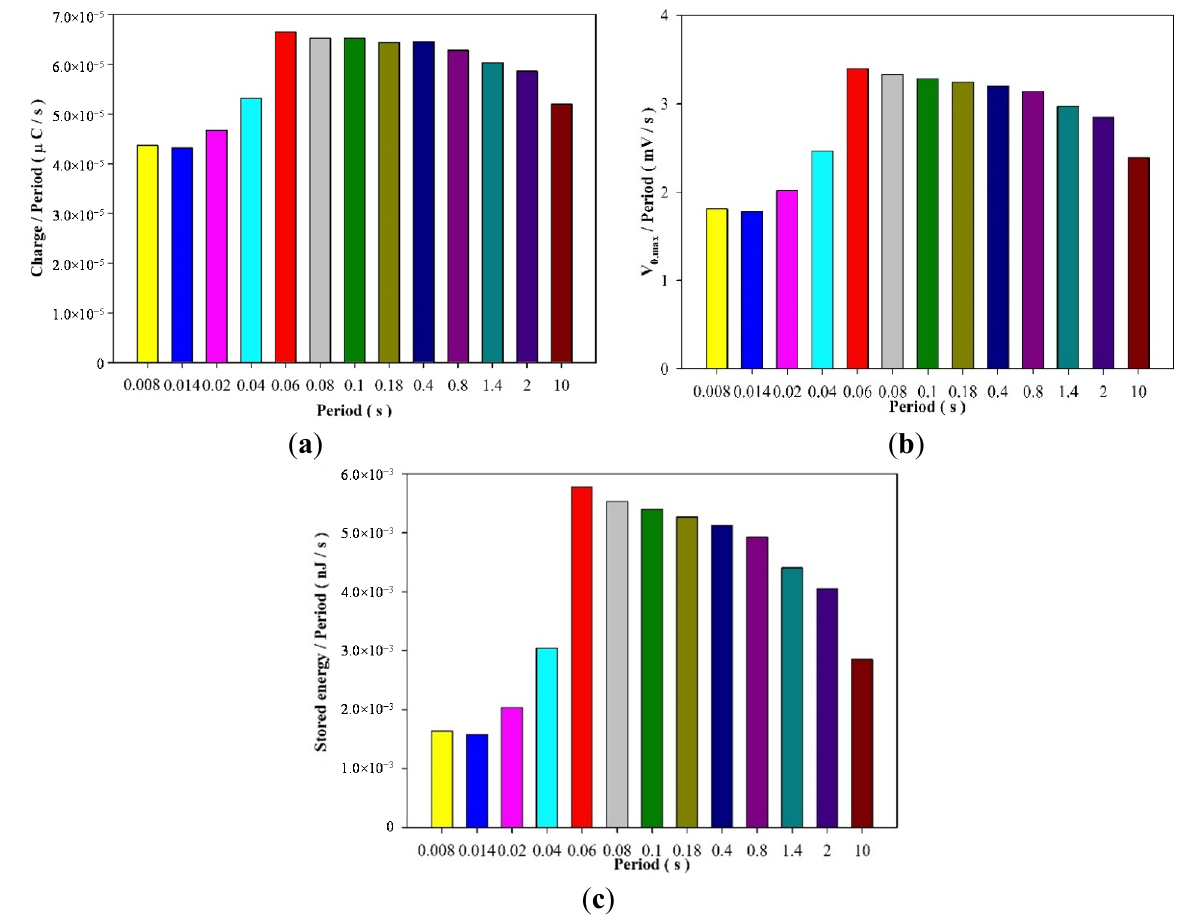
Figure 6. Relationships among ( a ) the induced charge per period; ( b ) the output voltage per period; ( c ) the stored energy per period and various periods for the 200 μ m thick PZT cell used for constructing the analysis model.